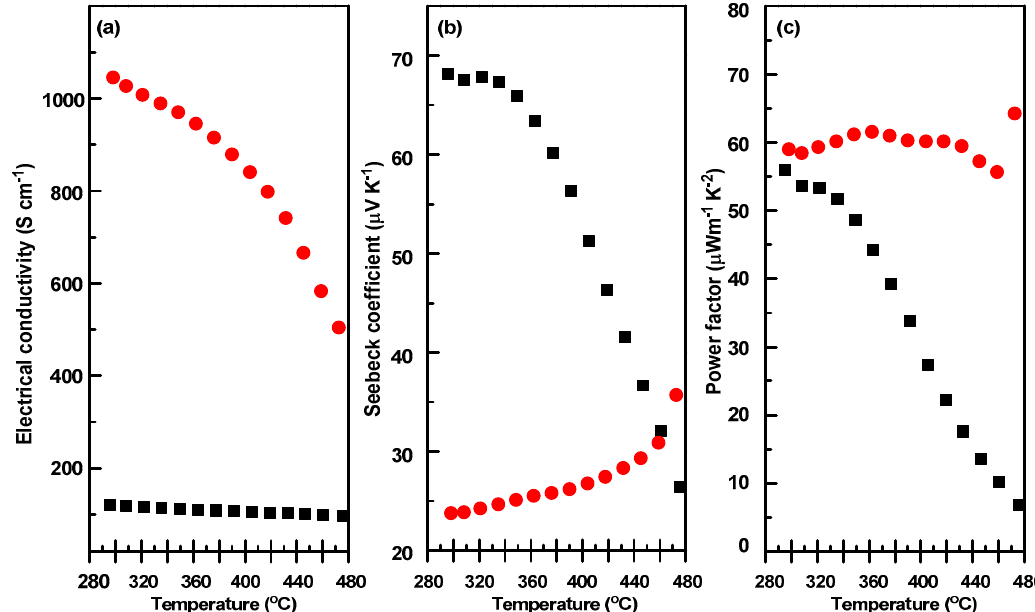
Figure 4. ( a ) Electrical conductivity, ( b ) Seebeck coe ffi cient and ( c ) power factor of the pristine composites (black) and F 4 TCNQ-doped composites (red).